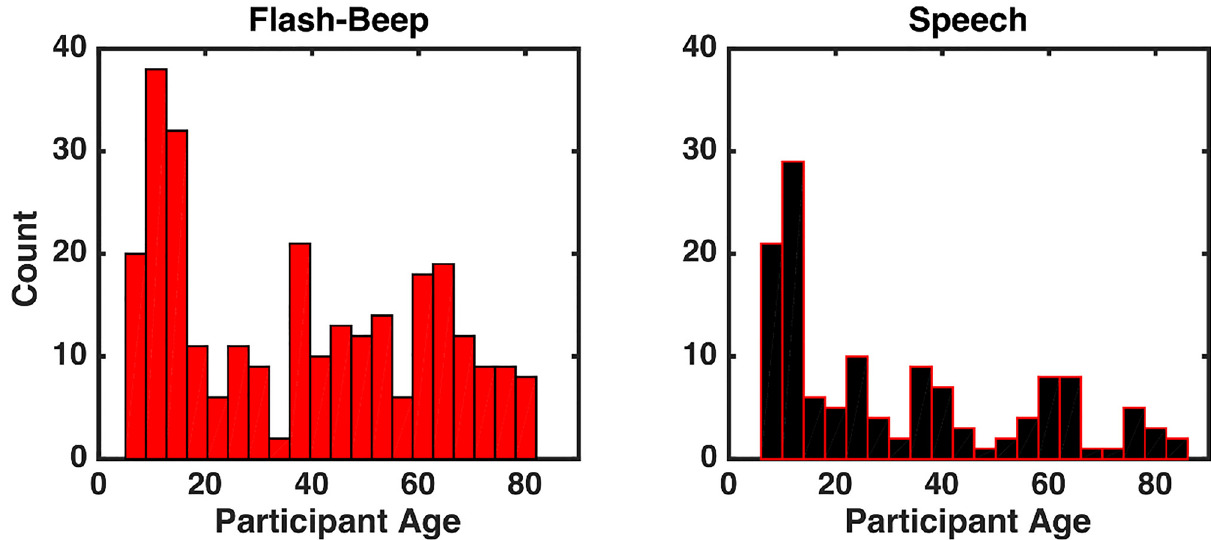
Fig 1. Histogram of participants ’ age as a function of stimulus type. A) Distribution of the ages of participants who were presented with Flash-Beep stimuli. B) Distribution of the ages of participants who were presented with Speech